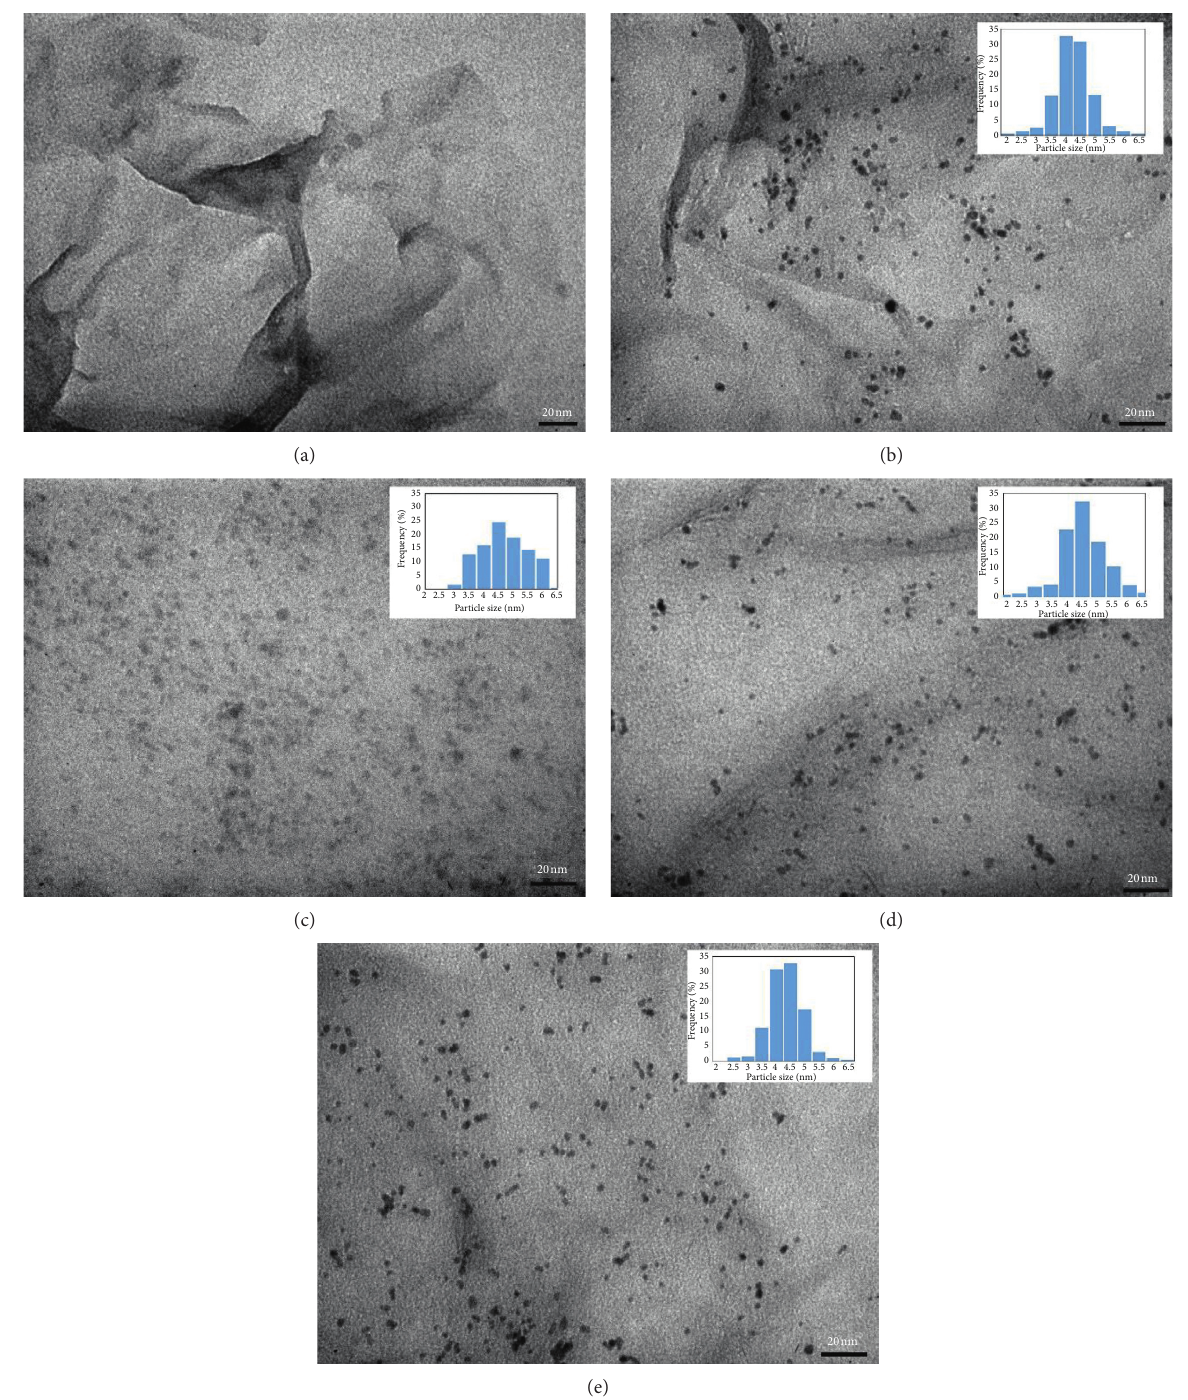
Figure 4: TEM image of GO (a), CI-WATER (b), CI-NBA (1/1) (c), CI-IPA (1/1) (d), and CI-EtOH (1/1) (e) catalyst